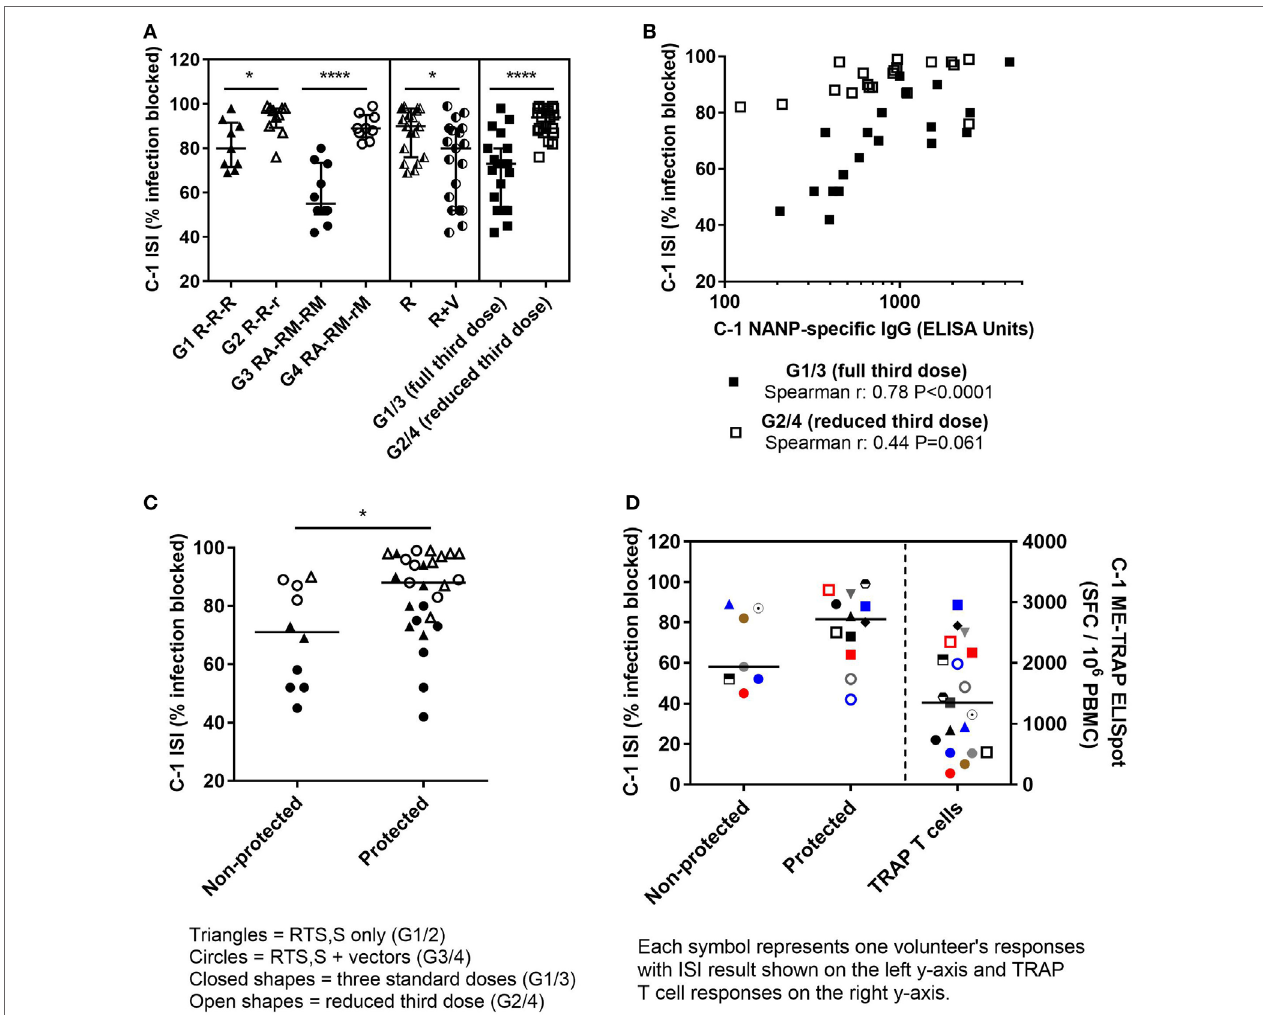
FigUre 3 | ISI results. (a) Percentage of sporozoite invasion into hepatoma cells that was blocked by serum at C-1. Comparison of groups given three standard doses of RTS,S/AS01B or a reduced (1/5th) third dose of RTS,S/AS01B. Mann–Whitney analyses G1 R-R-R vs G2 R-R-r P = 0.014, G3 RA-RM-RM vs G4 RA-RM-rM P < 0.0001, G1/2 (R) vs G3/4 (R + V) P = 0.016, G1/3 (full third dose of RTS,S/AS01B) vs G2/4 (reduced third dose of RTS,S/AS01B) P < 0.0001, medians + IQRs. (B) Relationship between C-1 NANP IgG titers and sporozoite-blocking ability in individuals who received three full doses of RTS,S/AS01B with or without vectored vaccines (G1 and G3, closed squares, Spearman r : 0.78, P < 0.0001) or a reduced third dose of RTS,S/AS01B with, or without vectored vaccines (G2 and G4, open squares, Spearman r : 0.44, P = 0.061). (c) Percentage of sporozoite invasion blocked by C-1 serum protected and non-protected individuals, Mann–Whitney P = 0.017. Closed triangles: G1, open triangles: G2, closed circles: G3, open circles: G4. (D) Percentage of sporozoite invasion blocked by serum at C-1 in protected and non-protected volunteers in G3/4, R + V (left Y -axis) and corresponding TRAP T cell responses (right Y -axis) at C-1 for each volunteer measured by IFN γ ELISpot, summed responses from T9/96 TRAP pools + ME, spot-forming cells per million PBMC (SFC/10 6 PBMC), lines at medians. Abbreviations: R G1/2, RTS,S/AS01B vaccinated; R + V G3/4, RTS,S/AS01B and viral-vectored vaccines co-administered; R2V, RTS,S/AS01B and viral-vectored vaccines at a 2-week stagger; A, ChAd63 ME-TRAP; M, MVA ME-TRAP; R, 50 µg third dose of RTS,S/AS01B; r, 10 µg third dose of RTS,S/AS01B; CHMI, controlled human malaria infection; C-1: day before CHMI; ISI, inhibition of sporozoite invasion; PBMCs, peripheral blood mononucleocytes; TRAP, thrombospondin- related adhesive protein; IQRs, inter-quartile